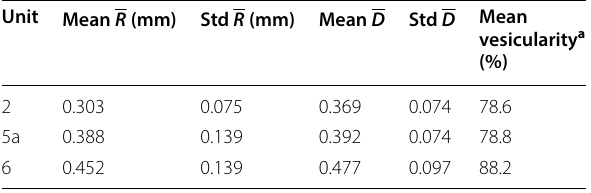
Mean arithmetic mean, Std standard deviation a Measured by the Archimedes method (Houghton and Wilson